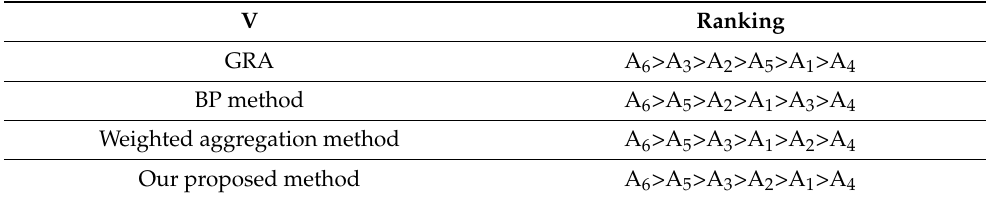
Table 11. The ranking of the elements according to conditional